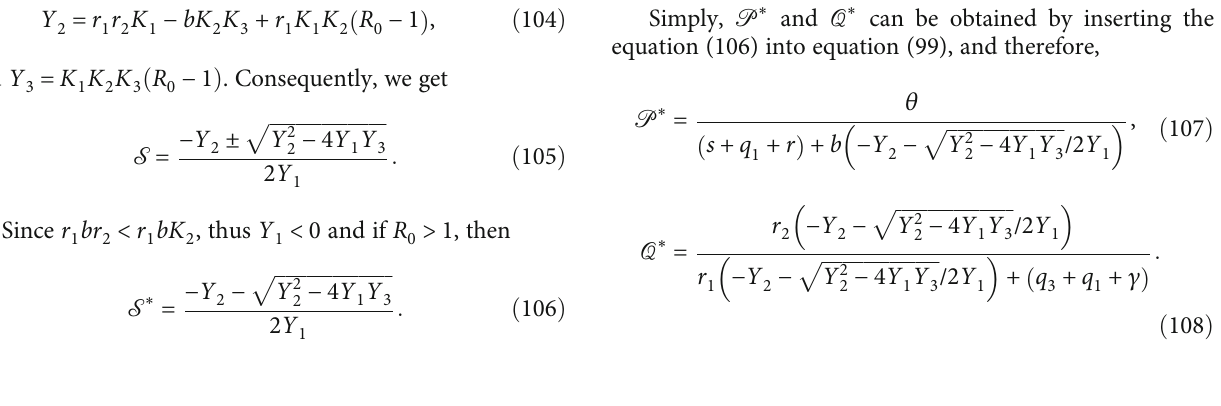
0 by 3D plot and the contour of